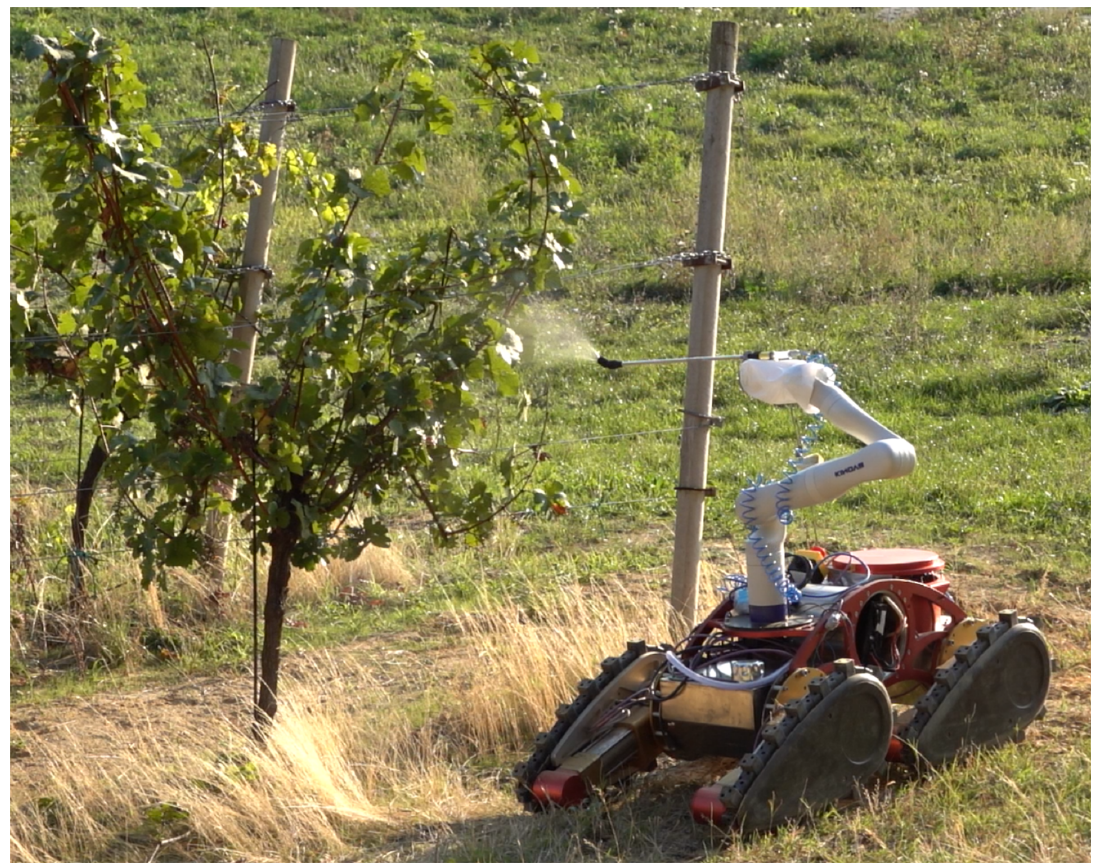
Figure 8. Mobile manipulator performing a spraying experiment in a vineyard.